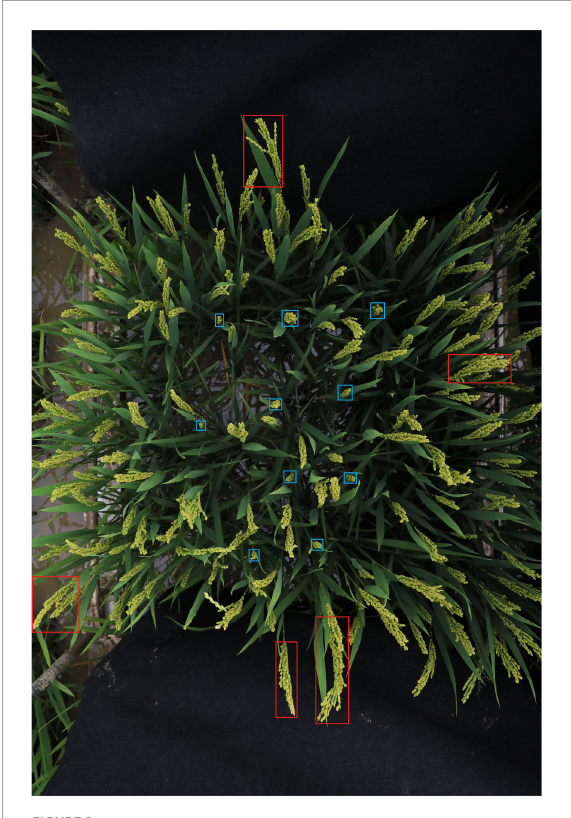
FIGURE2 Example of rice field image. The size of rice panicles varies greatly. Red boxes show examples of large panicles and blue boxes show examples of small